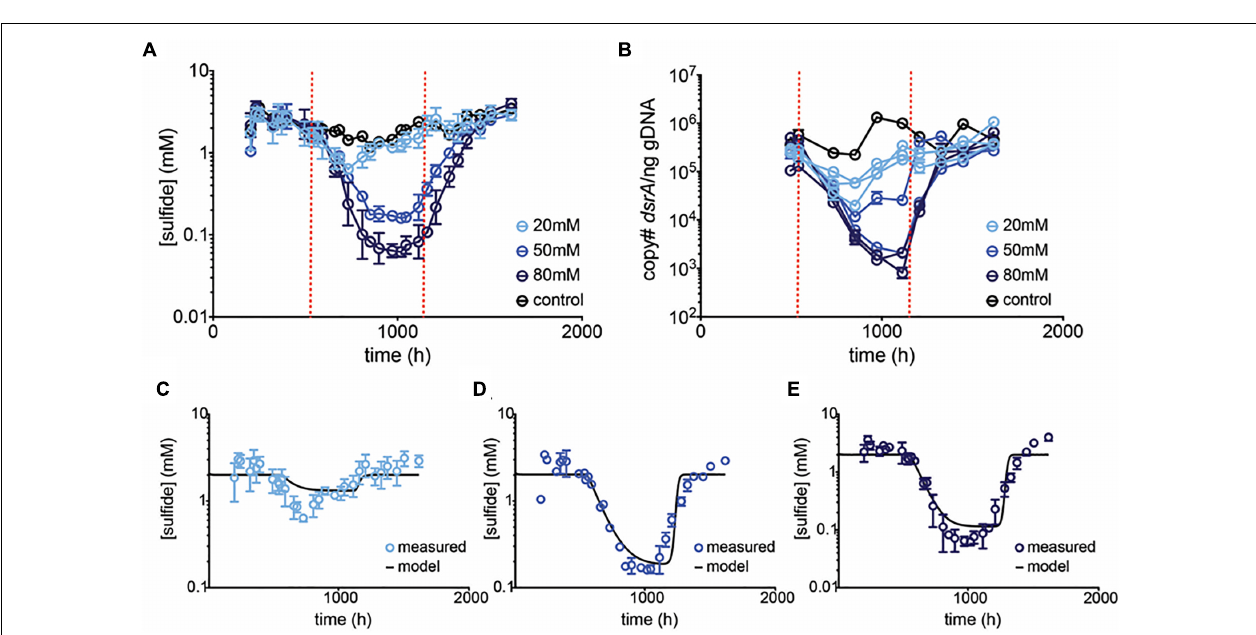
FIGURE 3 | Average (A) sulfide production, and (B) dsrA copy number per ng gDNA in control (black circles) and treated (blue circles) chemostats. Dashed red lines indicate start and stop of treatment. Error bars represent SD from 3 replicates for 20 and 80 mM treatments and the range of 2 replicates for 50 mM treatment. In (B) replicates are plotted independently. Model prediction (black line) and empirical data (blue circles) of [ sulfide ] over time at (C) 20 mM, (D) 50 mM, and (E) 80 mM perchlorate are compared. Model assumes a K p of 40%, a K A of 0.5%, and µ of 0.13.